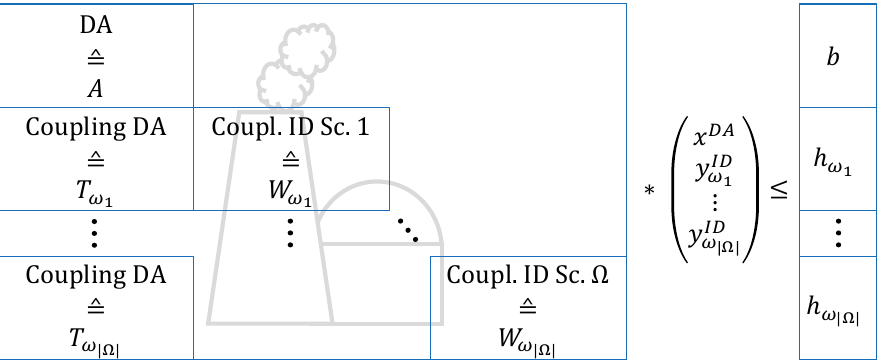
Figure 6. Blockangular structure of the stochastic power plant